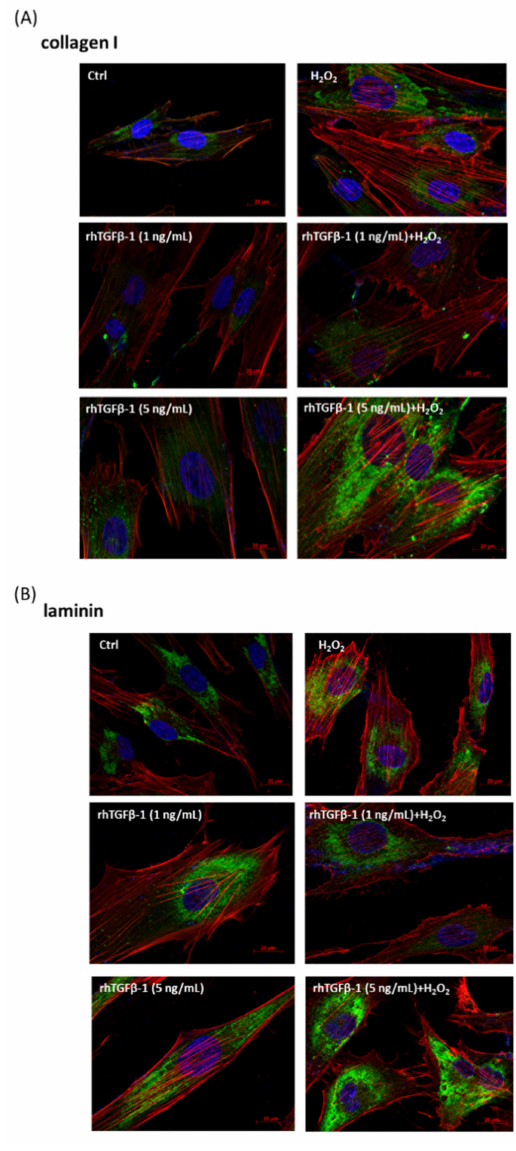
Figure 6. Immunofluorescence analysis of rhTGF- β 1 protein-treated HTMCs with or without H 2 O 2 exposure (0.5 mM for 1 h). Fluorescence photomicrograph of HTMCs with rhTGF- β 1 treatment at different concentrations (1, 5 ng/mL) with or without H 2 O 2 treatment (0.5 mM) for 1 h. HTMCs were treated with specific conditions on 12 mm coverslips fixed and stained with ( A ) collagen I (green), ( B ) laminin (green), phalloidin (red), and DAPI (blue). The same exposure was used for each set of fields, and the images are indicative of three different fields (scale bar = 20 µ